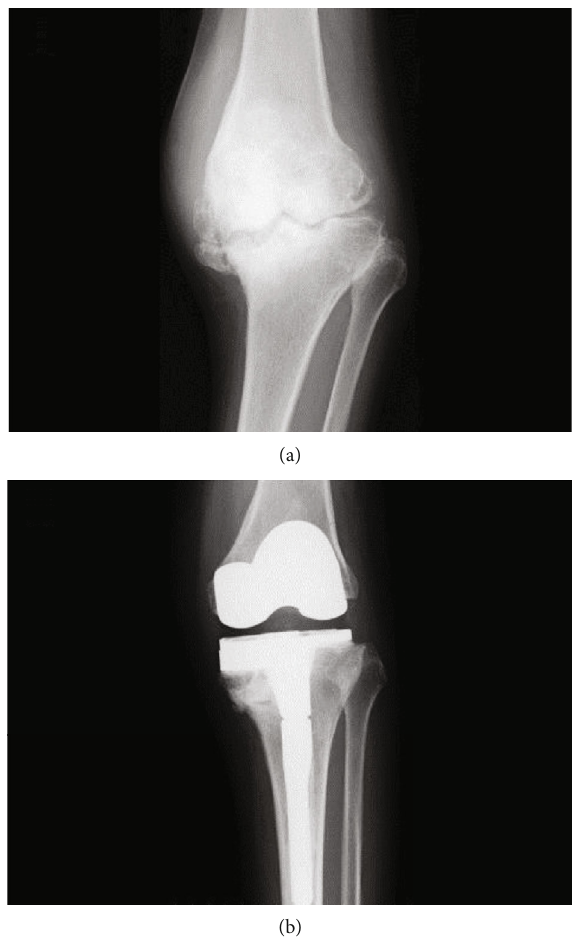
Figure 2: (a) Preoperative radiograph of the right knee showing mild varus. (b) Postoperative radiograph after right TKA.